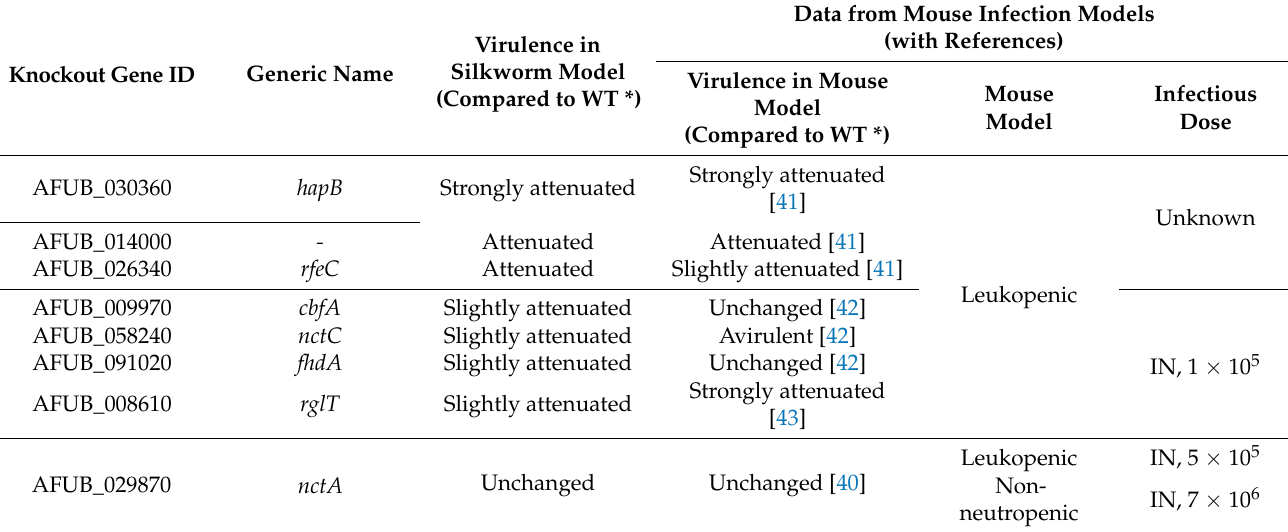
Table 1. Virulence of A. fumigatus knockout mutants in silkworm vs. in mouse